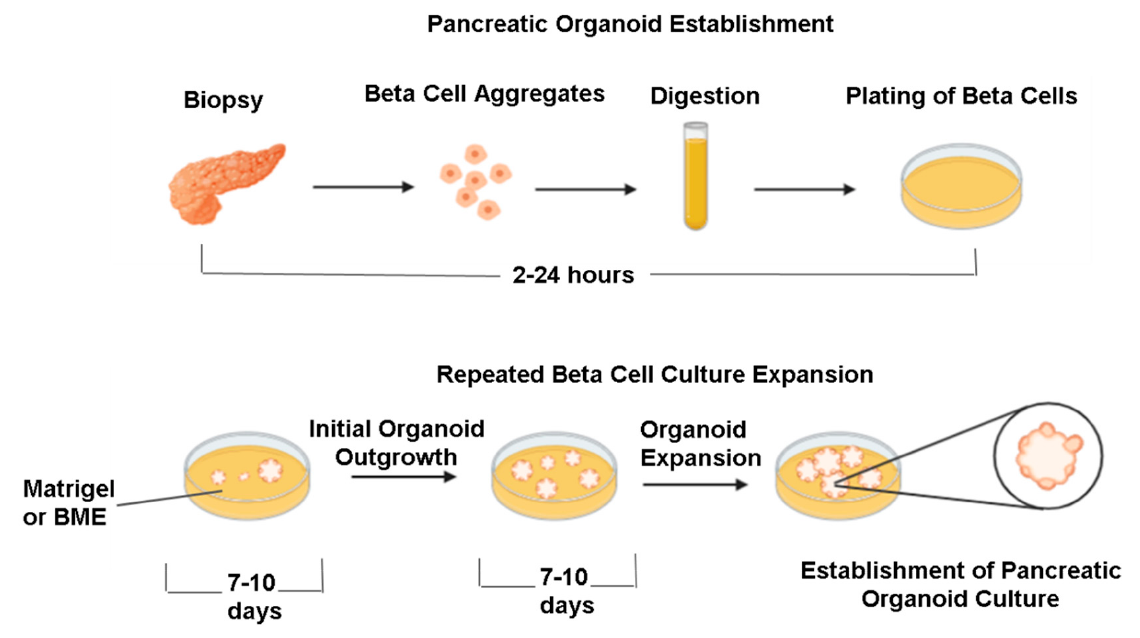
Figure 2. Generation of pancreatic organoids: Pancreatic organoids can be generated from primary fetal and adult pancreatic tissue or pancreatic ductal adenocarcinoma. The source of the starting tissue dictates the distinction between organoid morphology and its cellular composition. Organoids established from normal pancreatic tissue are grown on a medium containing growth factors. After the initial organoid outgrowth, they are expanded on Matrigel or BME. Normal pancreatic organoids have cystic structures and are visible 7–10 days after plating. After expansion, the pancreatic organoids can be characterized and used for downstream applications or cryopreserved for biobanking.